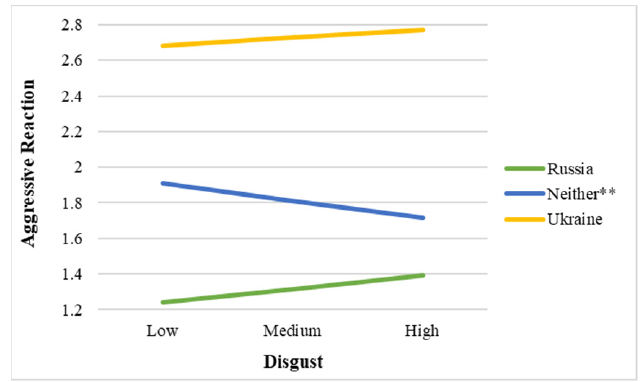
Figure A3. Plot of the relationship between Cognitive Reappraisal and Disgust at low ( − 1 SD), me- dium (mean), and high (+1 SD) Appraisal of Own Emotion score; * = p < 0.05.